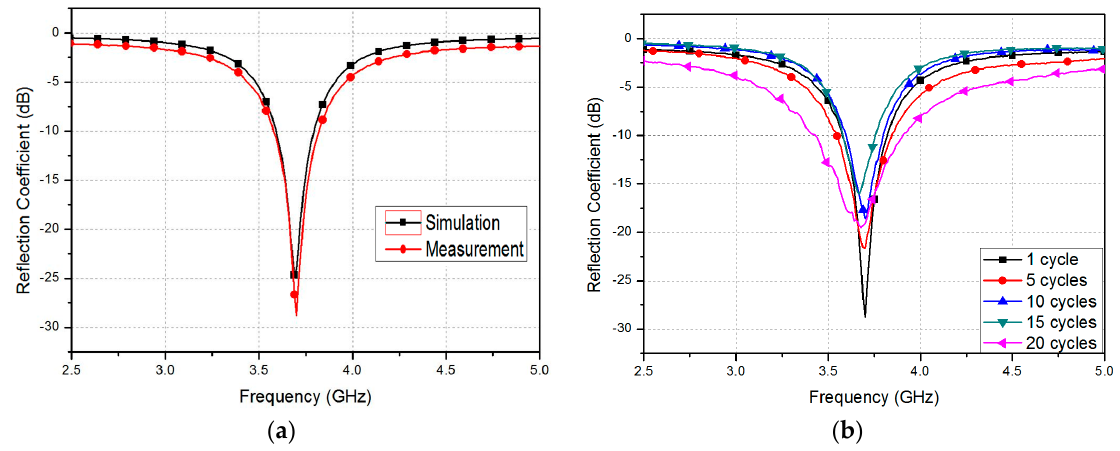
Figure 6. ( a ) Simulated and measured reflection coefficients of the proposed patch resonator before stretching; ( b ) Repeatability test of the fabricated strain sensor.